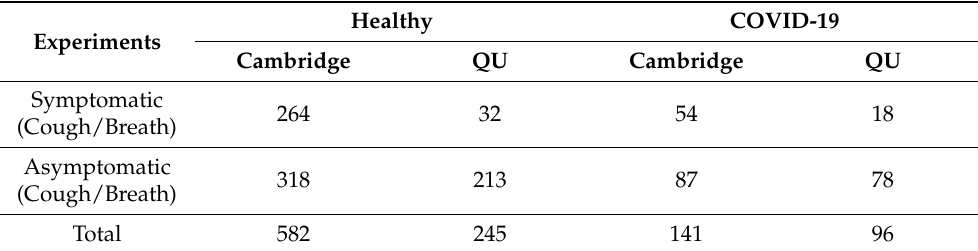
Table 1. Details of the total